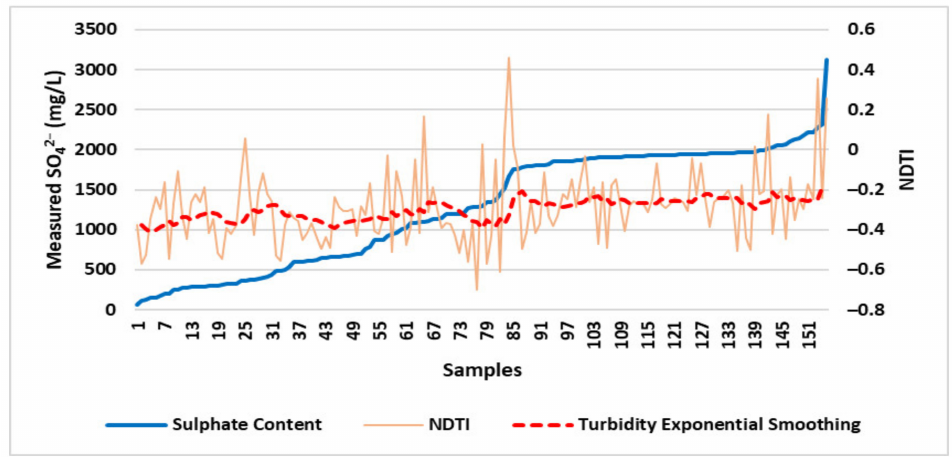
Figure 11. Comparison of the Sentinel-2 turbidity index (NDTI) and observed values of SO 42 − content from water